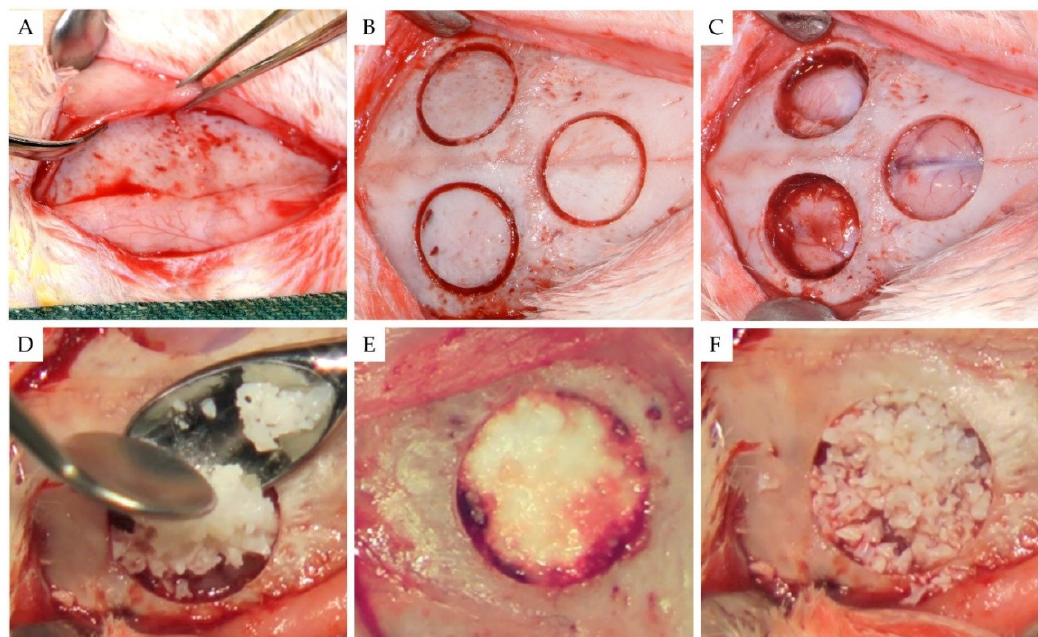
Figure 1. The surgical process. ( A ) Surgical exposure of the rabbit calvaria; ( B ) using a trephine burr, three identical circular osteotomies were performed; and ( C ) after removing the bicortical bone segments. The circular three-defect model was utilized with a frontal bone defect affecting the inter-frontal suture plus two bilateral defects affecting the parietal bones. ( D ) Two sites were treated with bone substitutes and the third left unfilled. ( E ) EthOss and ( F ) Bio-Oss.